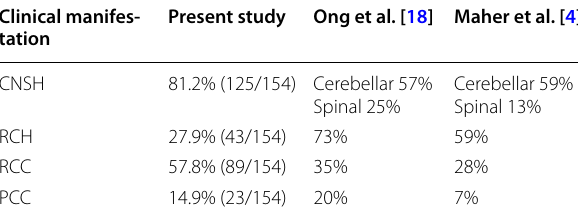
CNSH central nervous system hemangioblastoma, RCH retinal capillary hemangioblastoma, RCC renal cell carcinoma, PCC pheochromocytoma